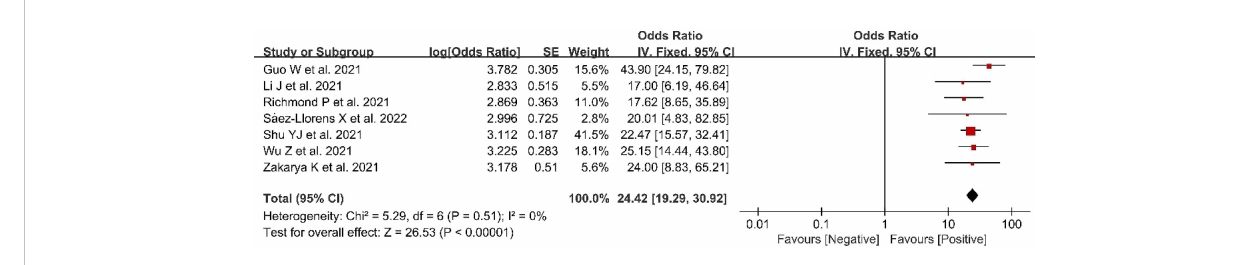
FIGURE 5 Forest plots of antibody seroconversion rate after coronavirus disease 2019 (COVID-19)